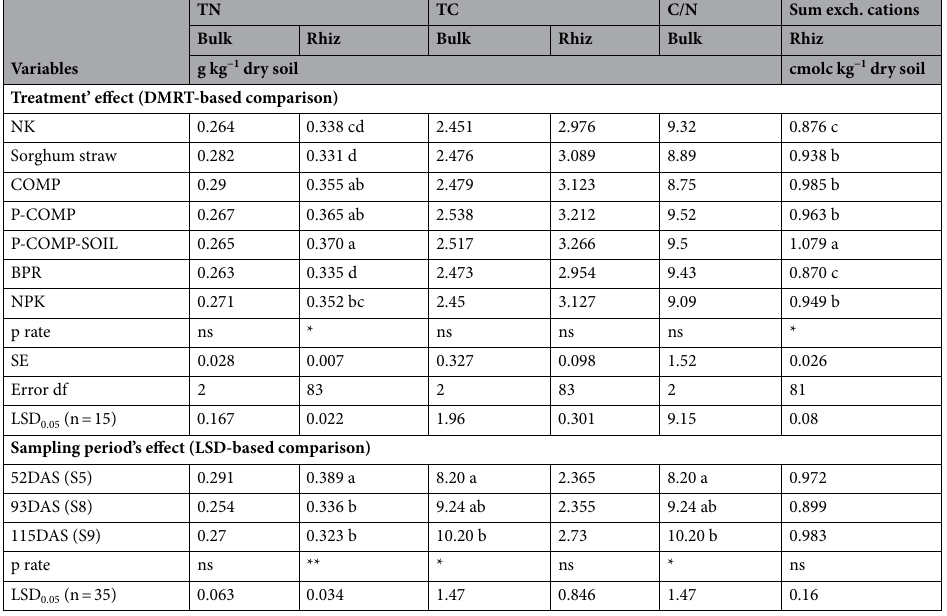
Table 2. Chemical properties of bulk and the rhizosphere soils following two-way Analysis of Variance (ANOVA). Within the same column, values assigned the same letter are not significantly different according to the Student–Newman–Keuls (SNK) test at the 5% probability level. Values assigned different letters differ highly significantly (**) at p < 0.01, and significantly (*) at p < 0.05, ns Not significant at p < 0.05. NK Without phosphate or compost addition, COMP Sorghum straw-based compost, P-COMP Sorghum straw-based compost + BPR, P-COMP-SOIL Compost made from sorghum straw, BPR, and sorghum rhizosphere soil, BPR Burkina phosphate rock, Rhiz Rhizosphere, DAS Days after sowing, [ S5, S8, S9 ] = stage 5 (boot), stage 8 (hard dough), and stage 9 (physiological maturity) of the sorghum variety kapelga , SE Standard error, df Error